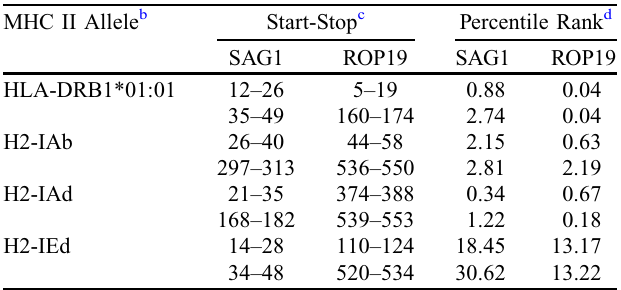
Table 2. IC 50 values for ROP19 binding to MHC class II molecules obtained using the immune epitope database a .